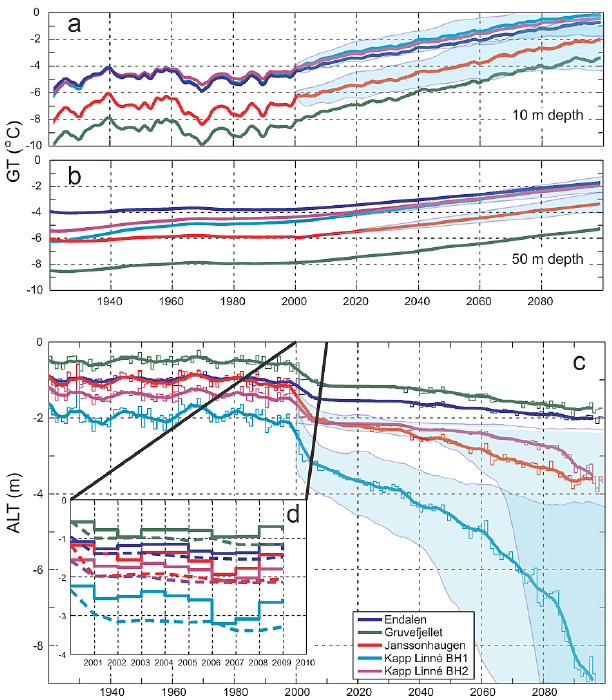
Fig. 5. Evolution of ground temperatures and ALT 1912–2099. Un- til 2000 the model was driven by instrumental data, from 2000 re- sults of the scenario runs are shown. All series were smoothed with a 24 months Gaussian filter. (a) Ground temperature development since 1912 in 10m and (b) 50m depth. The shaded areas illus- trate the spread of model results between the 10% and 90% per- centiles. The shaded area is only given for the Kapp Linn´e BH1 and the Janssonhaugen site. (c) Modelled maximum active layer thickness during the same period. The shaded area illustrates the modelled ALT spread for the 10% and 90% percentile scenario re- sults for the Kapp L. BH1 site (gray, bedrock site) and the Kapp L. BH2 (yellow, sediment-covered site). (d) Comparison between modelled ALT based on instrumental data (solid line) and median GCM scenario run (stippled line) in the overlap period 2000–2010.